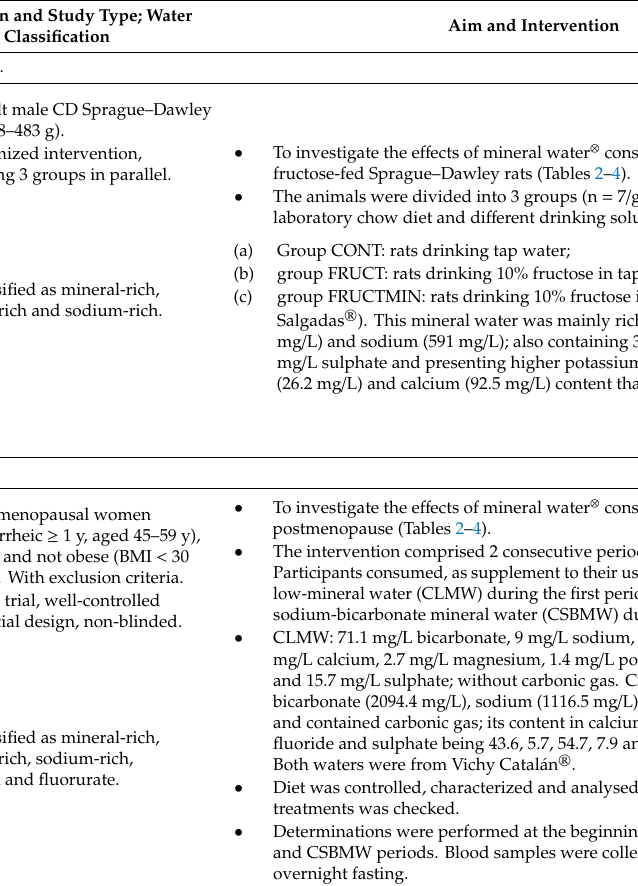
Table 1. The influence of mineral water consumption upon blood